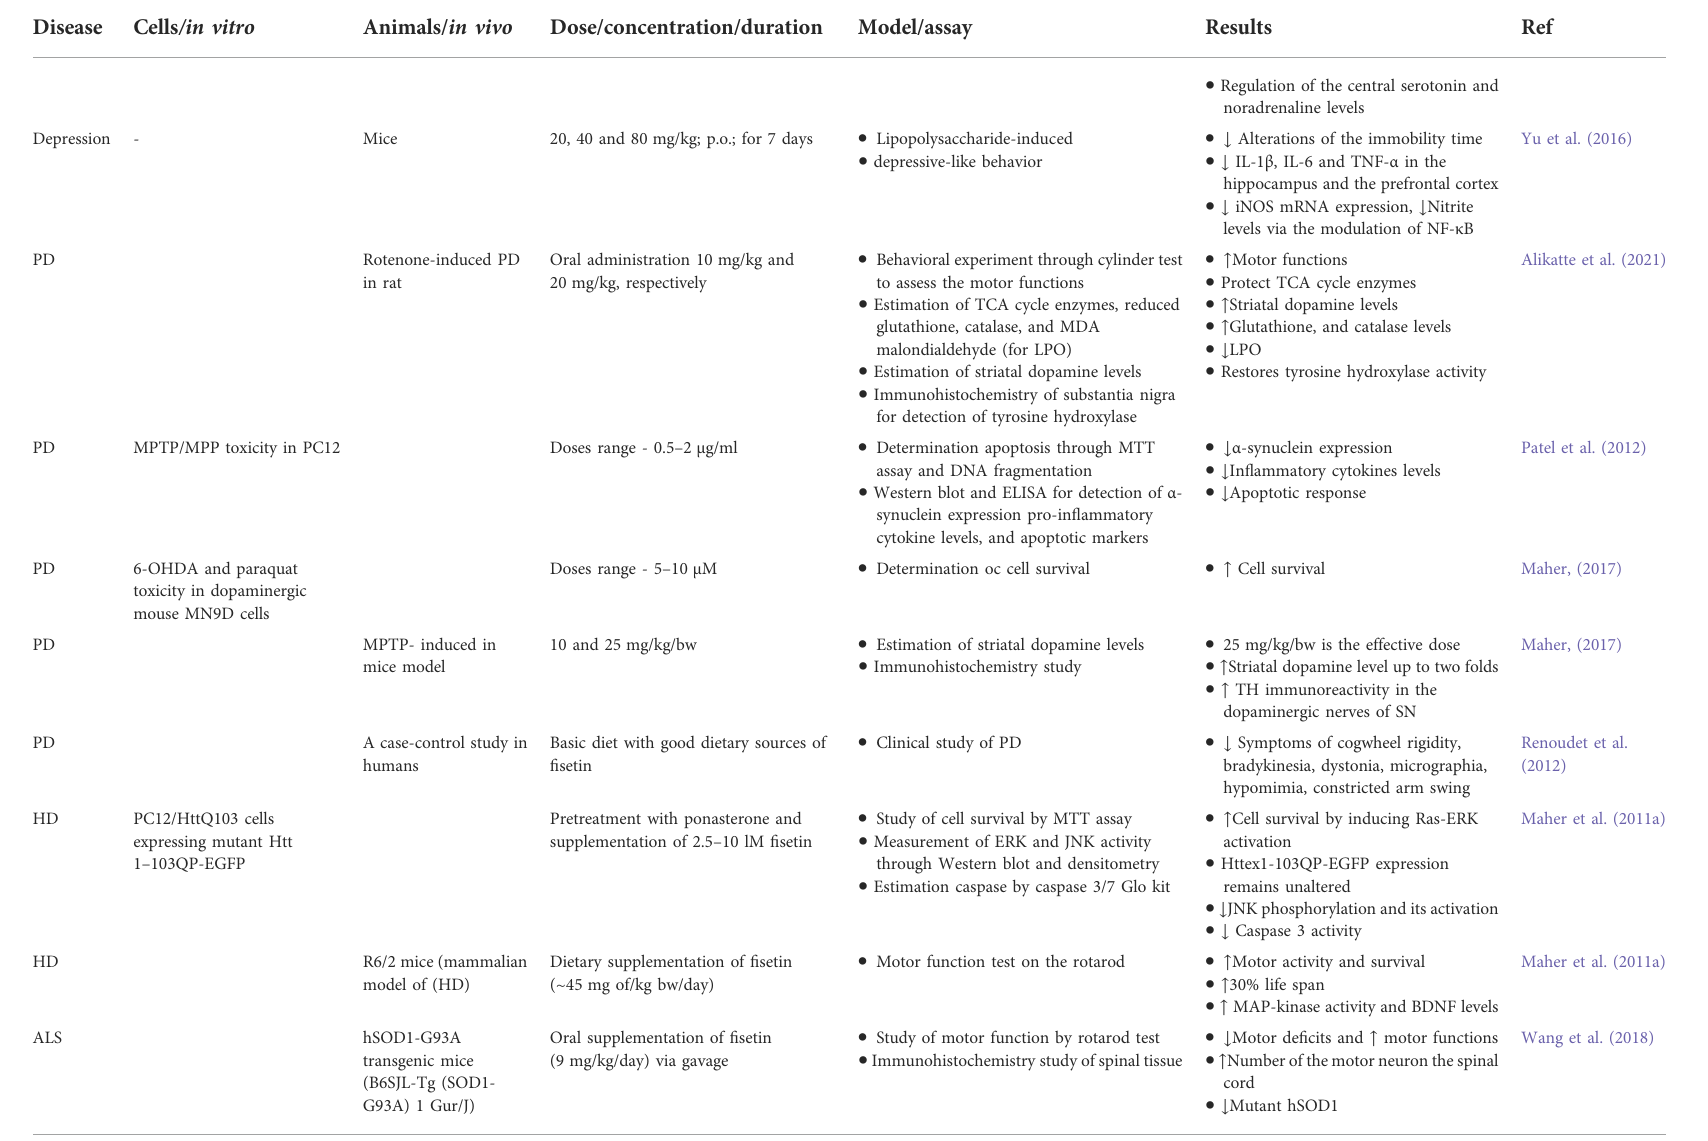
TABLE 1 ( Continued ) Different neurodegenerative disease and the protective role of fi